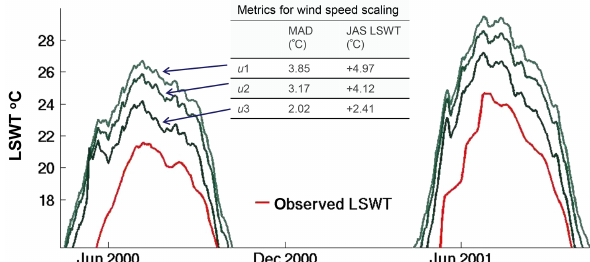
Figure 10. Effect of wind speed scalings on the modelled lake sur- face water temperature (LSWT) for Lake Simcoe, Canada, 44 ◦ N 79 ◦ W (depth 25m), showing that the greatest wind speed scal- ing, u 3 ( U water = 1 . 62ms − 1 + 1 . 17 U land ) , in place of the unscaled wind speed, u 1, reduces the daily mean absolute difference and July–August–September LSWT mean difference by ∼ 50%. Mod- elled with untuned LSWT properties: mean lake depth ( Z d 1 ) , de- fault snow and ice albedo ( α 1) and light extinction coefficient are derived from Secchi disk depth data ( κ sd )